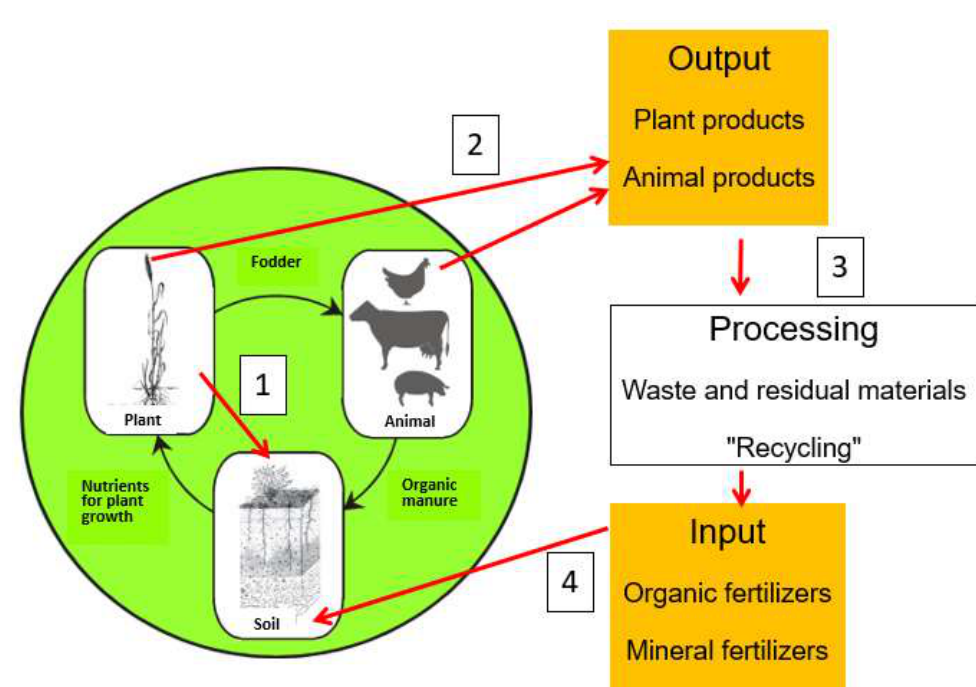
Figure 4. Symbolic representation of the internal and external nutrient cycle (1: Measures for securing soil fertility by closing the internal cycle; 2: By periodically exporting nutrients through product sales, the nutrient cycle is not closed; 3 and 4: A net supply of nutrients must come from newly created fertilizers from the recycling sector).